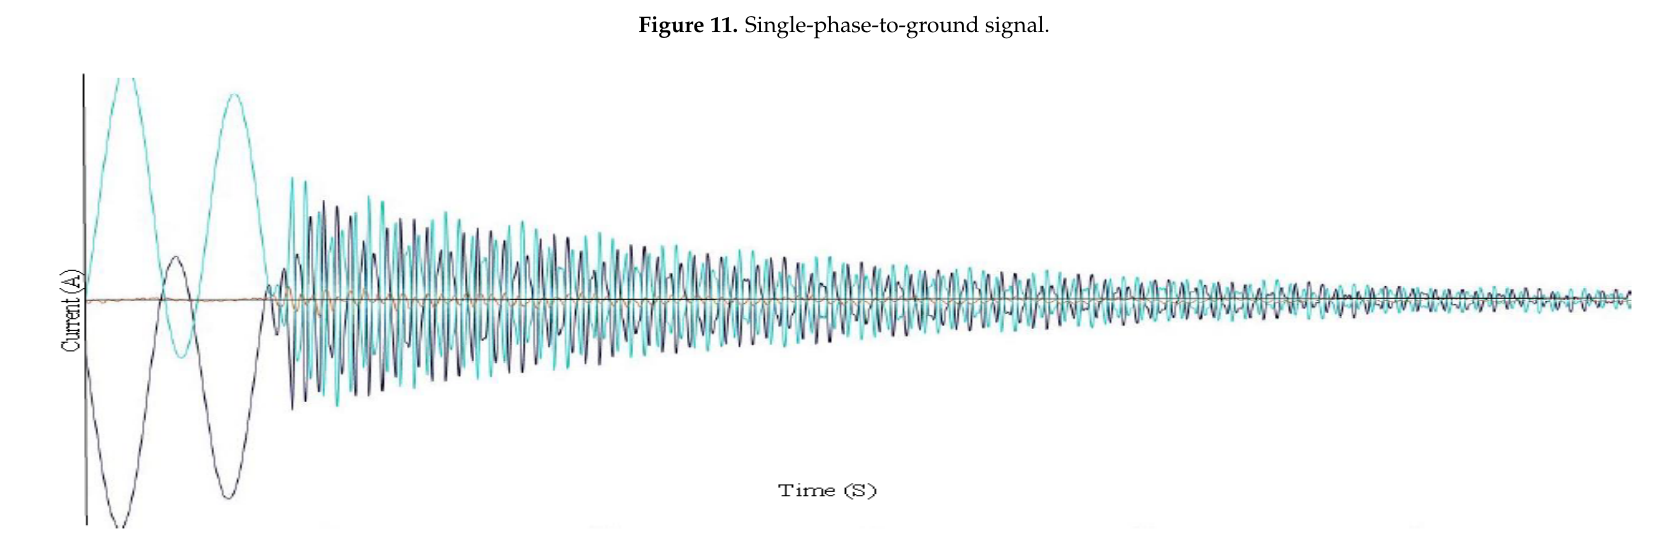
Figure 12. Double-phase-to-ground signal.